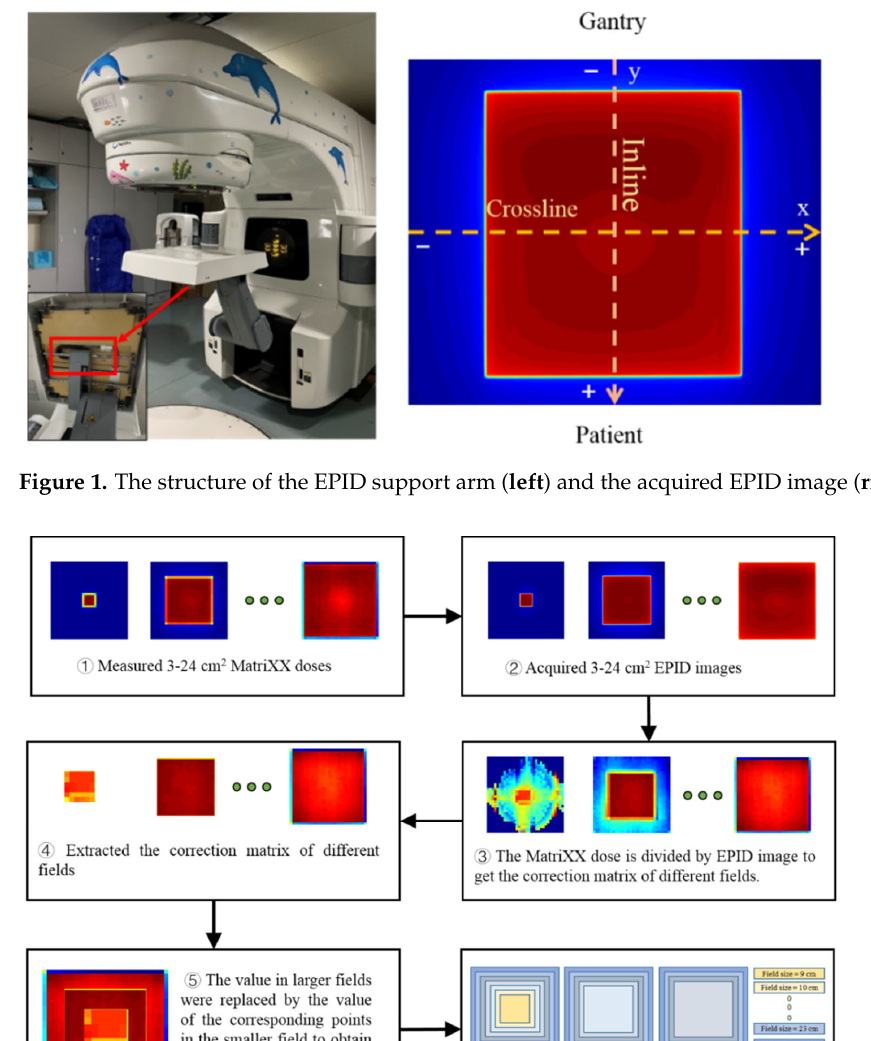
Figure 2. The generation process of the common correction matrix.